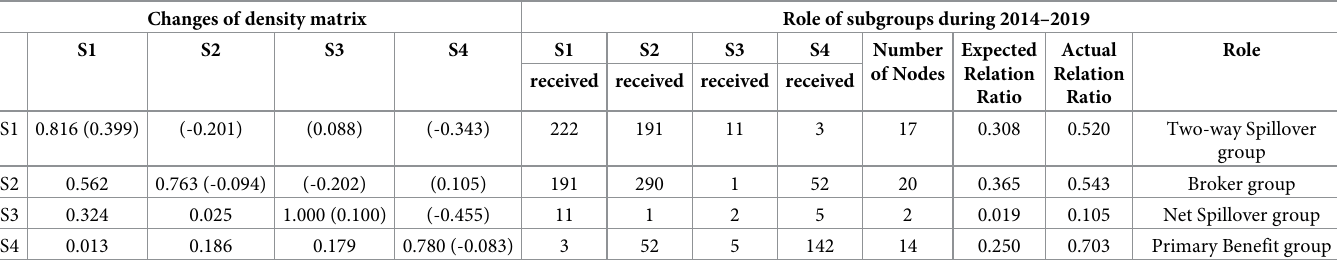
Table 3. Density matrix variation and group